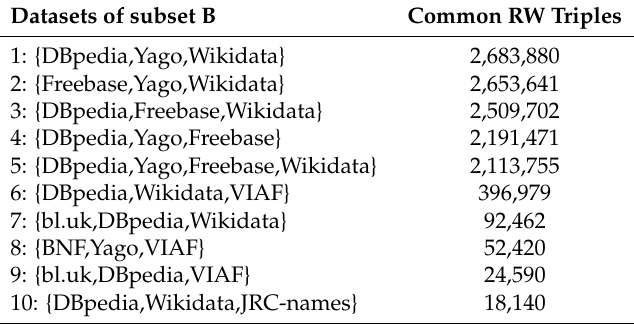
3 datasets having the most common real world ≥